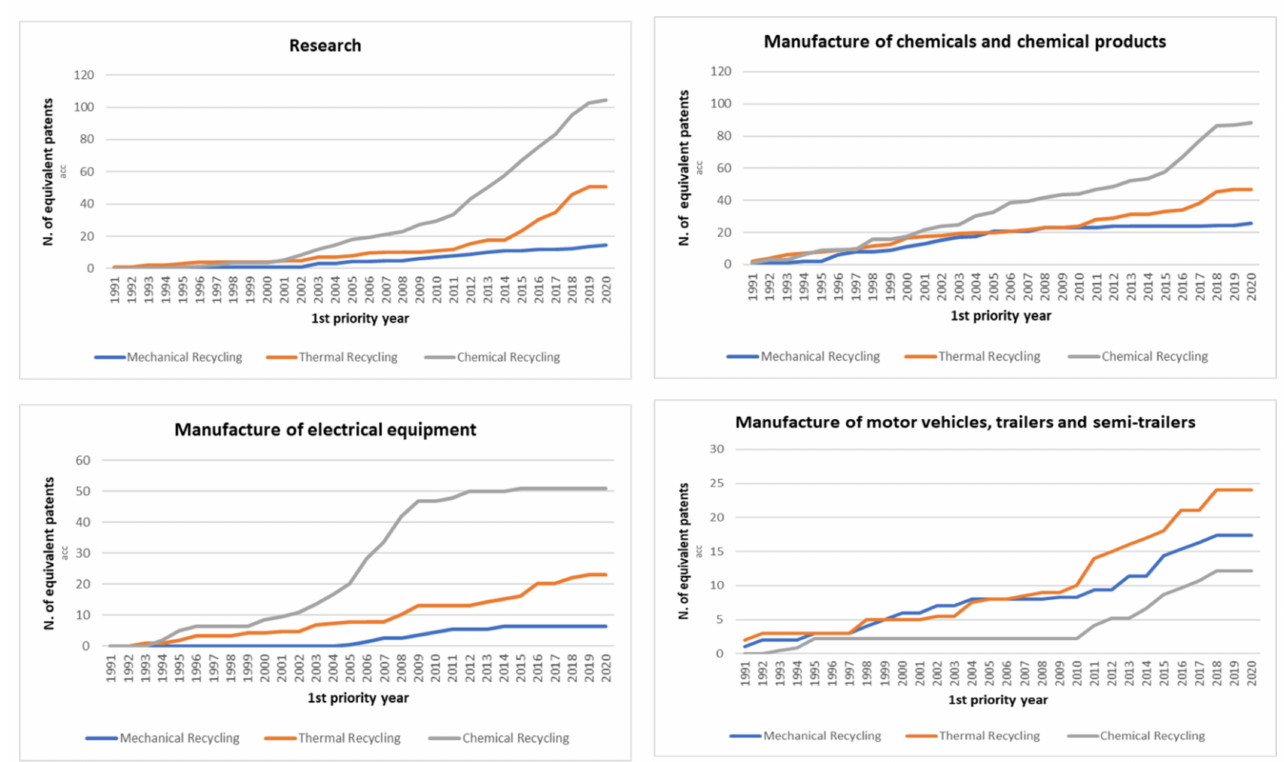
Figure 5. Cumulated patents for the main 4 assignee categories by recycling macro-category.